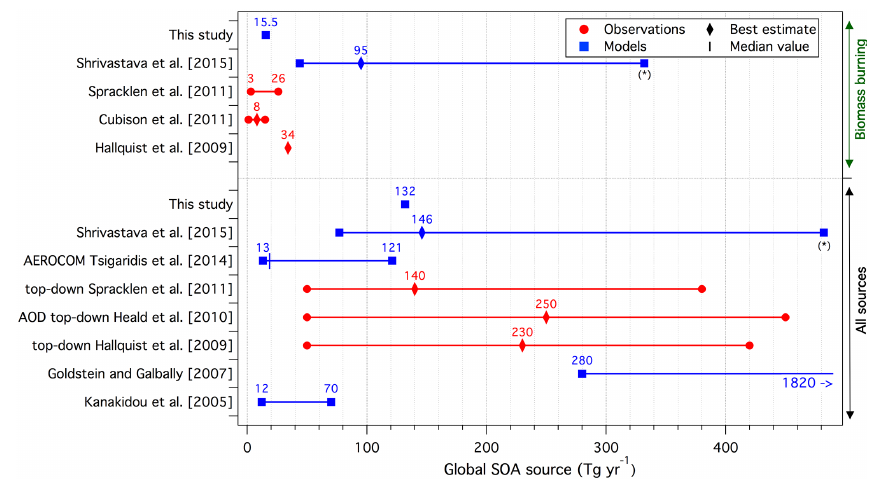
Figure 9. Global SOA particle-phase source (Tgyr − 1 ) as predicted in this study (NY_DPH) and as reported by previous studies. SOA production from all sources (anthropogenic, biomass burning, biofuel and biogenic) as well as from biomass burning alone is shown. ∗ The upper values shown for Shrivastava et al. (2015) are an absolute upper limit testing the sensitivity of SOA to the fragmentation of oxidized organic gases. In this case the fragmentation is omitted, leading to unrealistically high SOA production compared to the best-estimate run in which the fragmentational loss represents ∼ 270Tgyr − 1